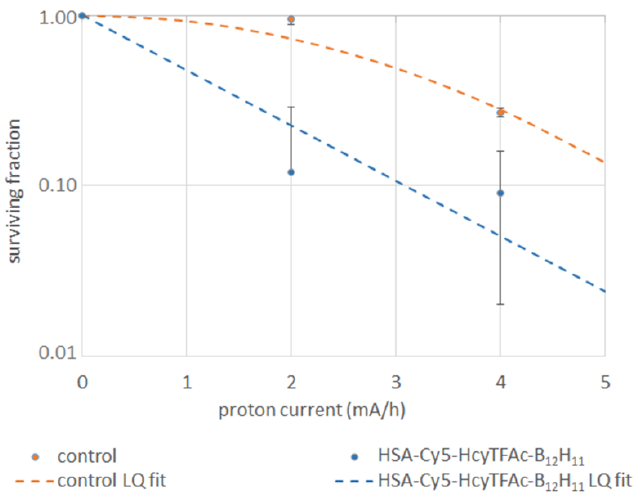
Figure 7. Survival curves of U87MG cells incubated with HSA-Cy5-HcyTFAc-B 12 H 11 conjugate (cyan curve) and without reagents (orange curve) depending on neutron fluence.